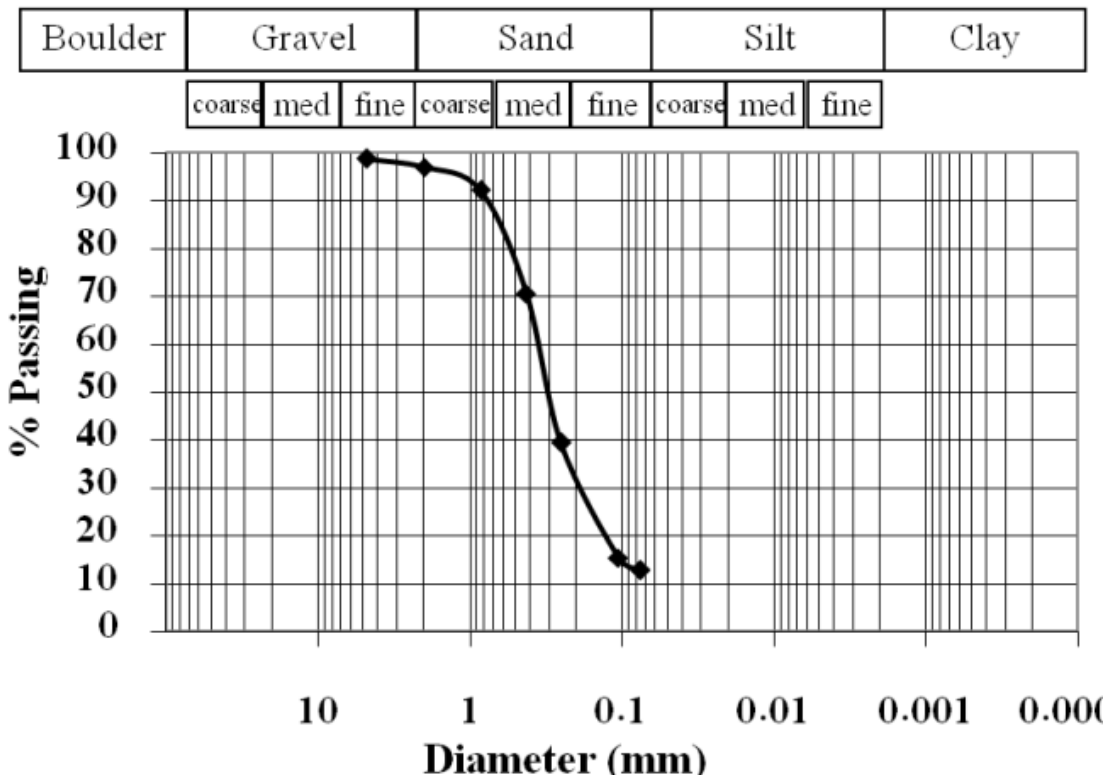
Figure 13. The sieve analysis of specimen 7 at 69.1E km at El- ferdan